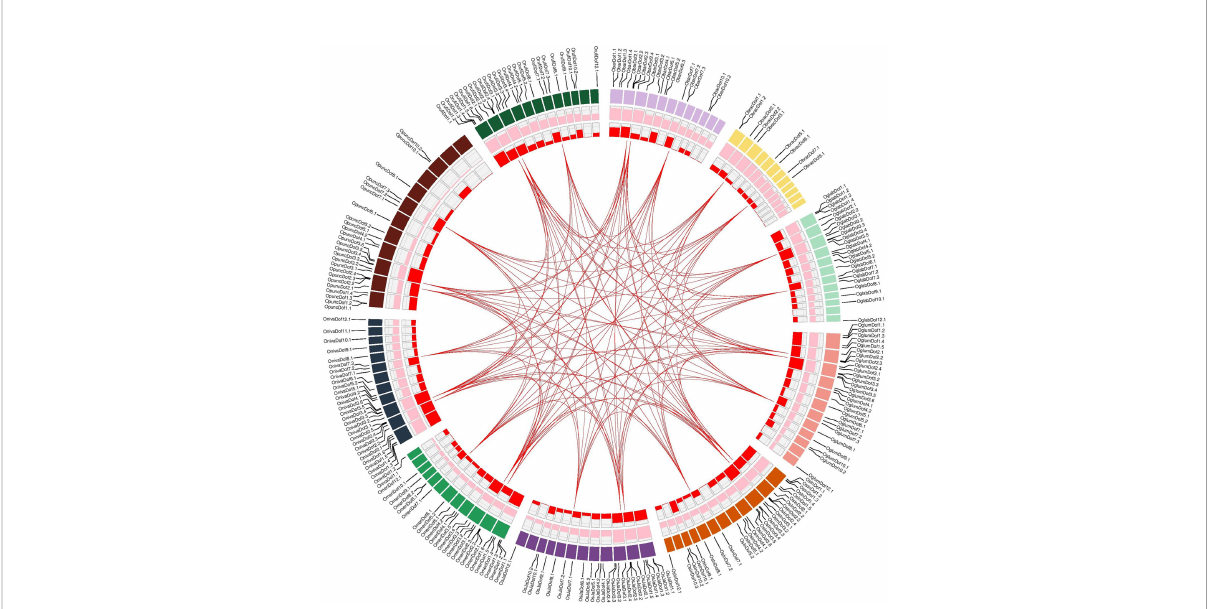
FIGURE 4 Genomic landscape of Dof genes among ten Oryza genomes. Circular diagram from outside to inside are gene names and locations on individual species-speci fi c colored chromosomal bands, density of high con fi dence protein-encoding genes (count/Mb; min = 65, max = 133), density of Dof genes (count/Mb; min = 0.0, max = 0.17) and links indicating duplicated genes among ten rice species. Detailed information about duplicated gene pairs is provided in Table